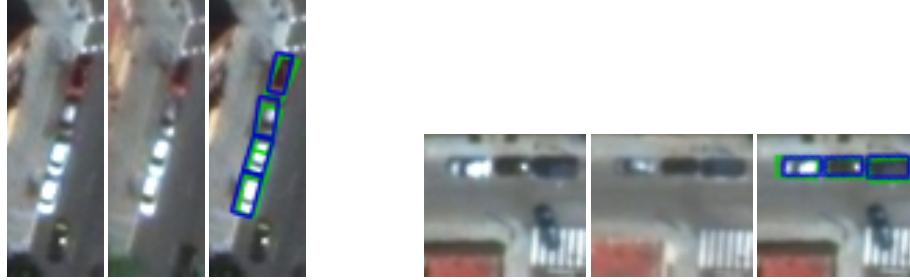
Figure 6. Two sample regions, where moving cars are effectively ruled out by our method and only parking cars are detected (from left to right: first stereo image, second stereo image, detections). Blue boxes depict ground truth, whereas green boxes depict the detections predicted with our early fusion methodology w/o